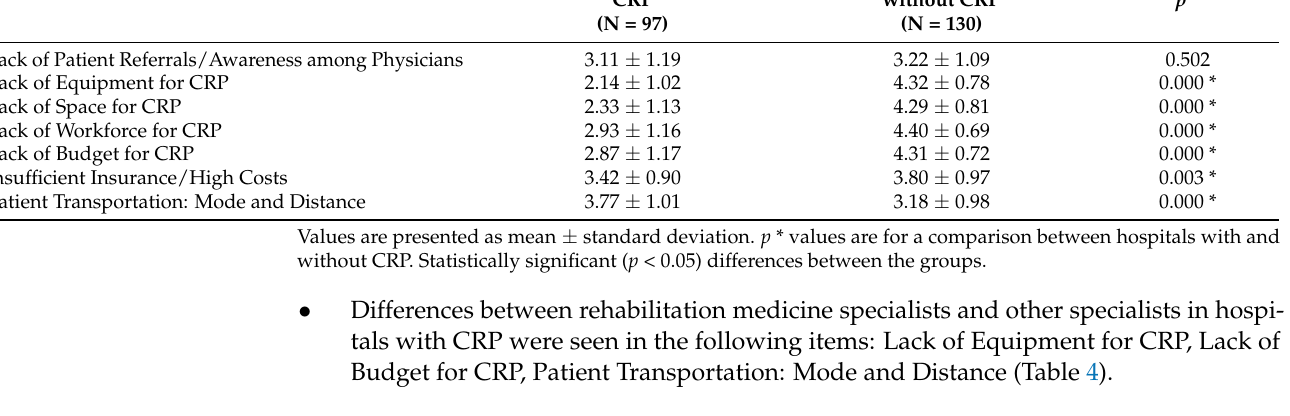
Table 4. Barriers and factors relating to cardiac rehabilitation at hospitals with cardiac rehabilitation programs